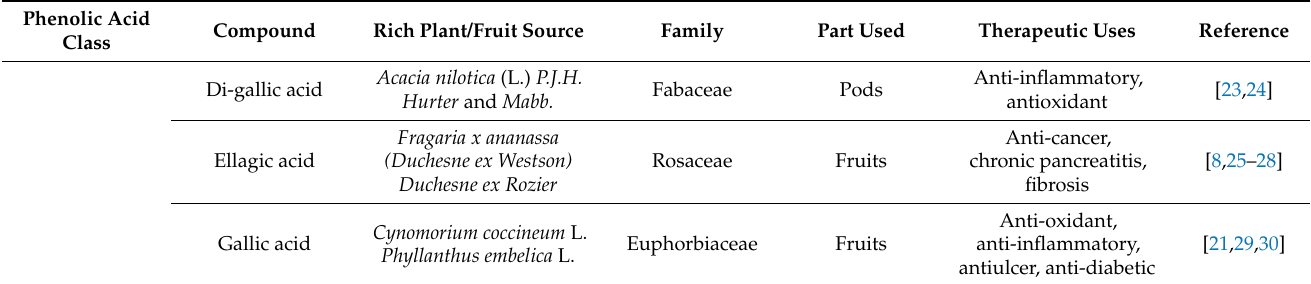
Table 1. Phenolic acids and their therapeutic